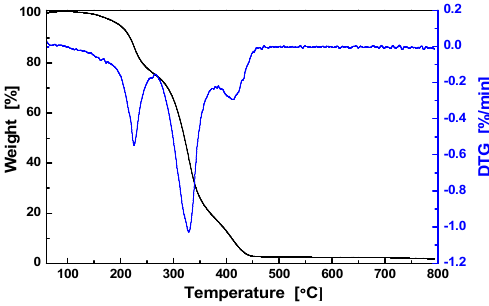
Figure 2. Thermogravimetric analysis curves of FHBPUA.